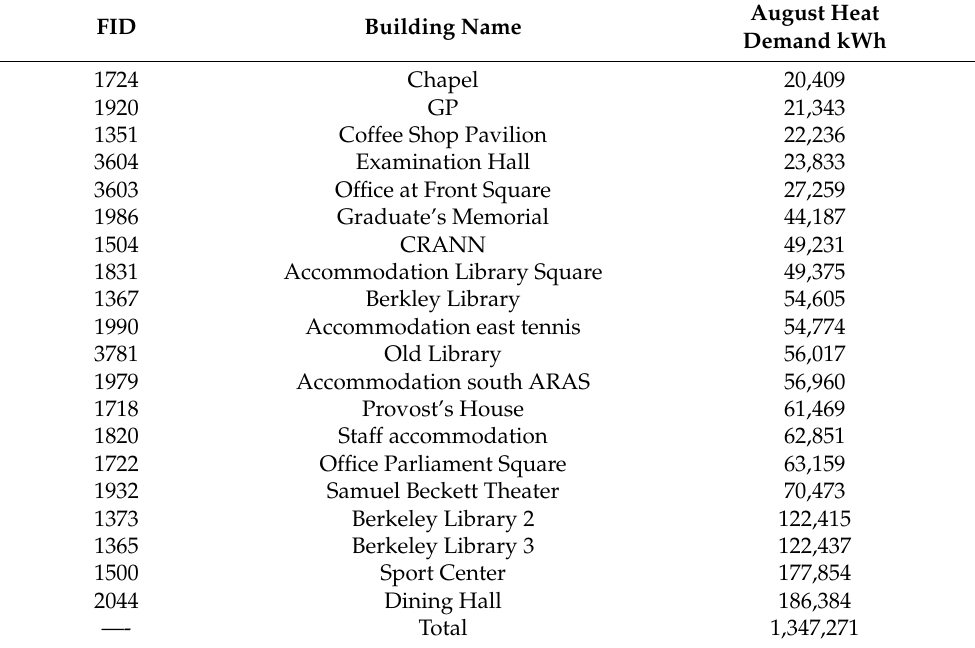
Table 3. The thermal energy demand in August at the building